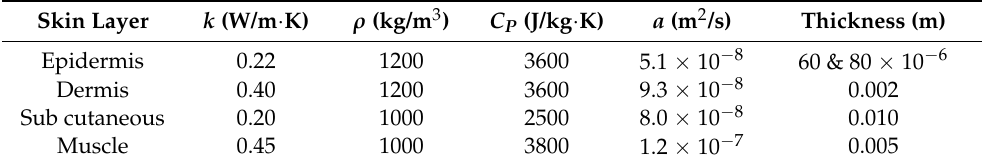
Table 1. Properties of the affected skin layers (thermal conductivity, k , density, ρ , and specific heat, C , from